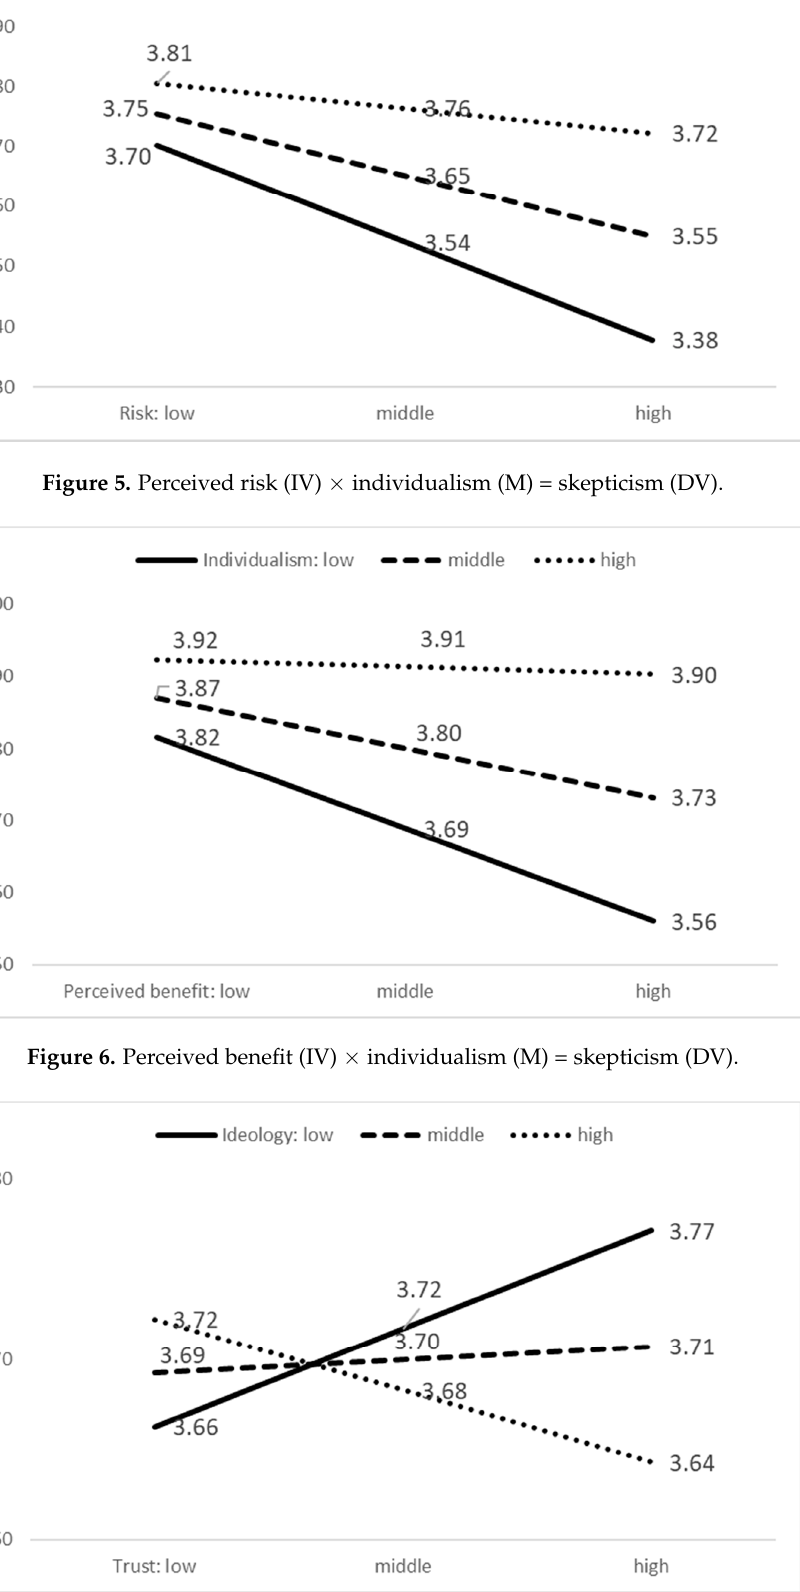
Figure 7. Trust (IV) × ideology (M) = skepticism (DV).